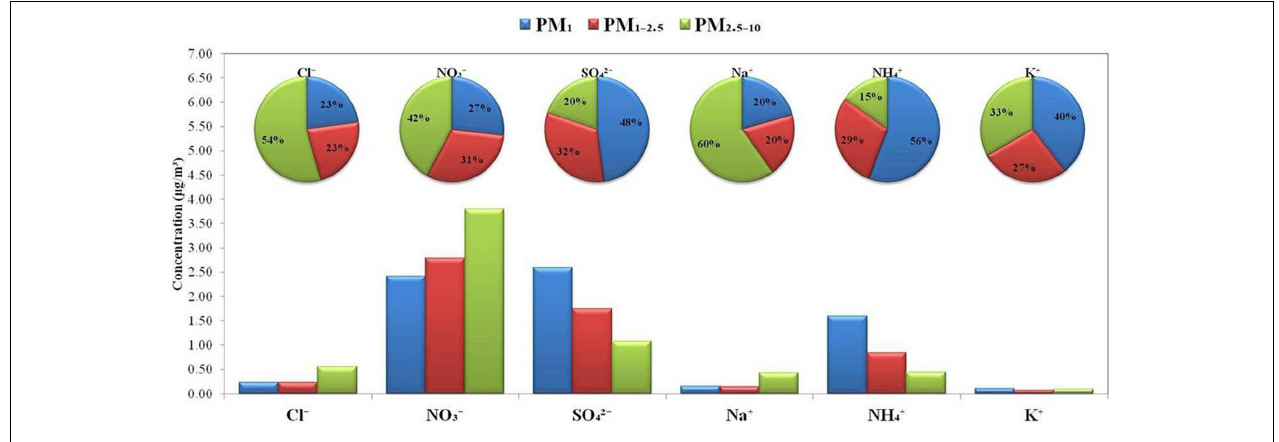
FIGURE 5 | Size distributions and contributions of the ionic